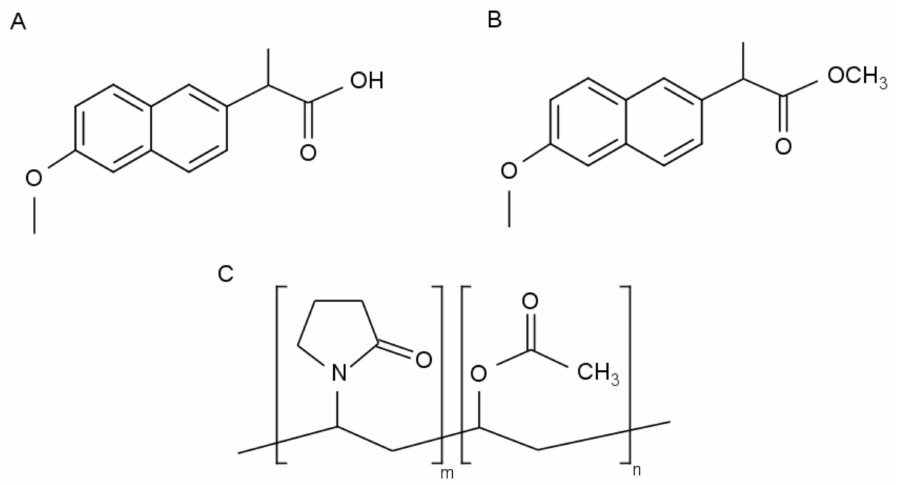
Figure 1. Structural formulas of ( A ) NAP, ( B ) NAPME and ( C )